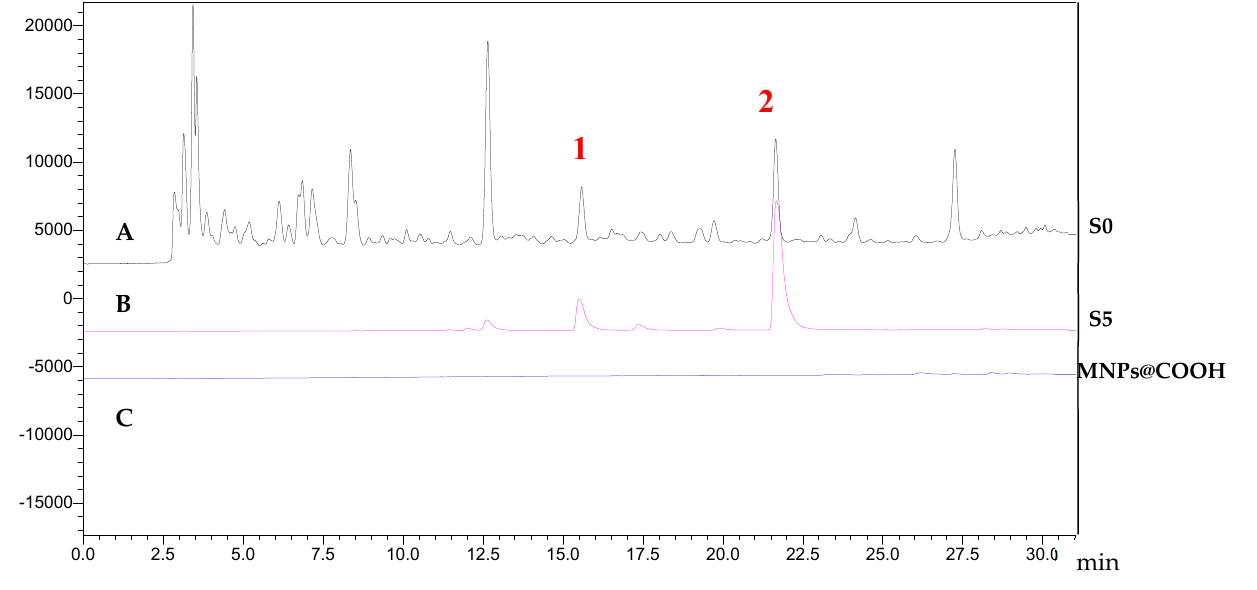
Figure 2. Chromatogram of S0 and S5 of n - BuOH fraction of N. glandulifera extract: ( A ) S0 refers to n - BuOH fraction; ( B ) S5 refers to components obtained from ligand fishing; ( C ) MNPs@COOH is the blank control for ligand fishing.